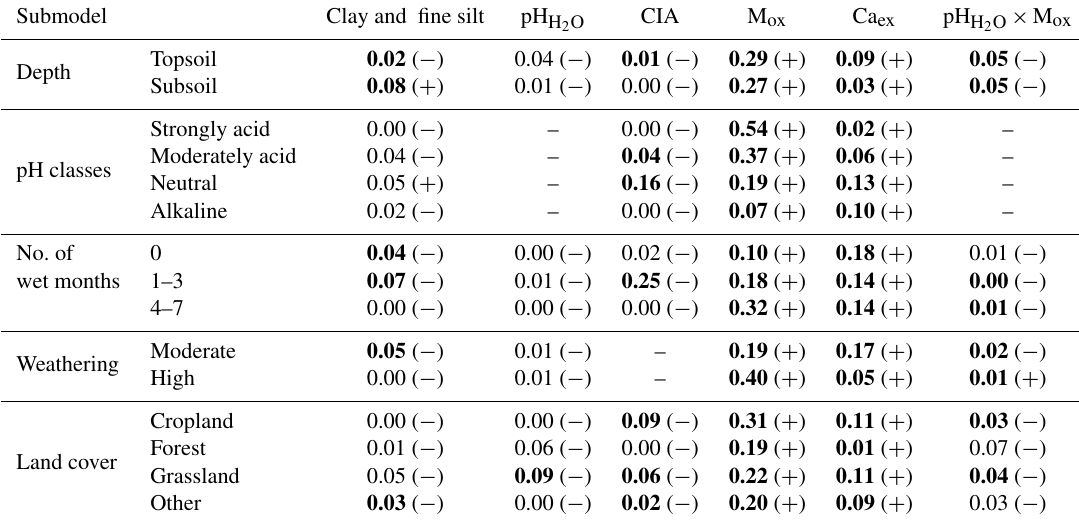
Table B2. Marginal R 2 for each fixed effect based on sequential fitting of the linear mixed-effects models for the different submodels (depth, pH classes, number of wet months, weathering and land cover). The sign in parentheses refers to the correlation between the fixed effect and soil organic carbon, respectively. Bold values have a p value < 0.0001 based on likelihood ratio